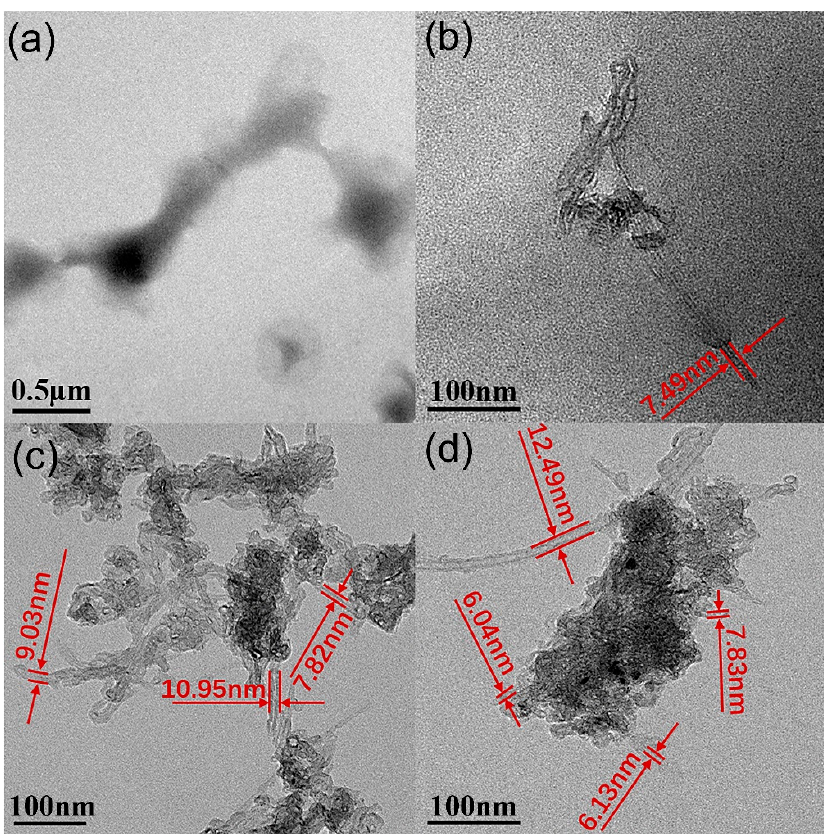
Figure 3. High-resolution transmission electron microscopy (HR-TEM) images of drug-loaded MPEG-PDLLA/c-MWCNT nanocomposites prepared at different mass ratios of c-MWCNTs/MPEG-PDLLA: ( a , b ) 0.02:1 and ( c , d ) 0.1:1.